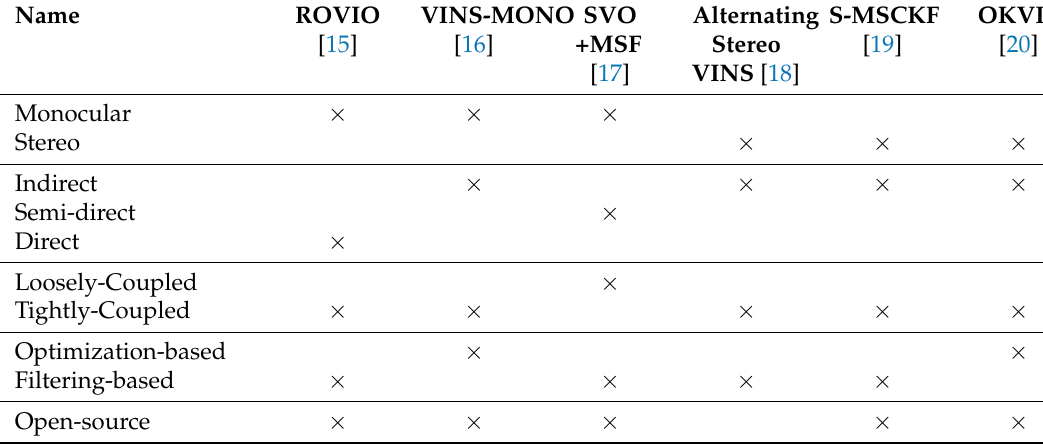
Table 1. State-of-the-art Visual-Inertial